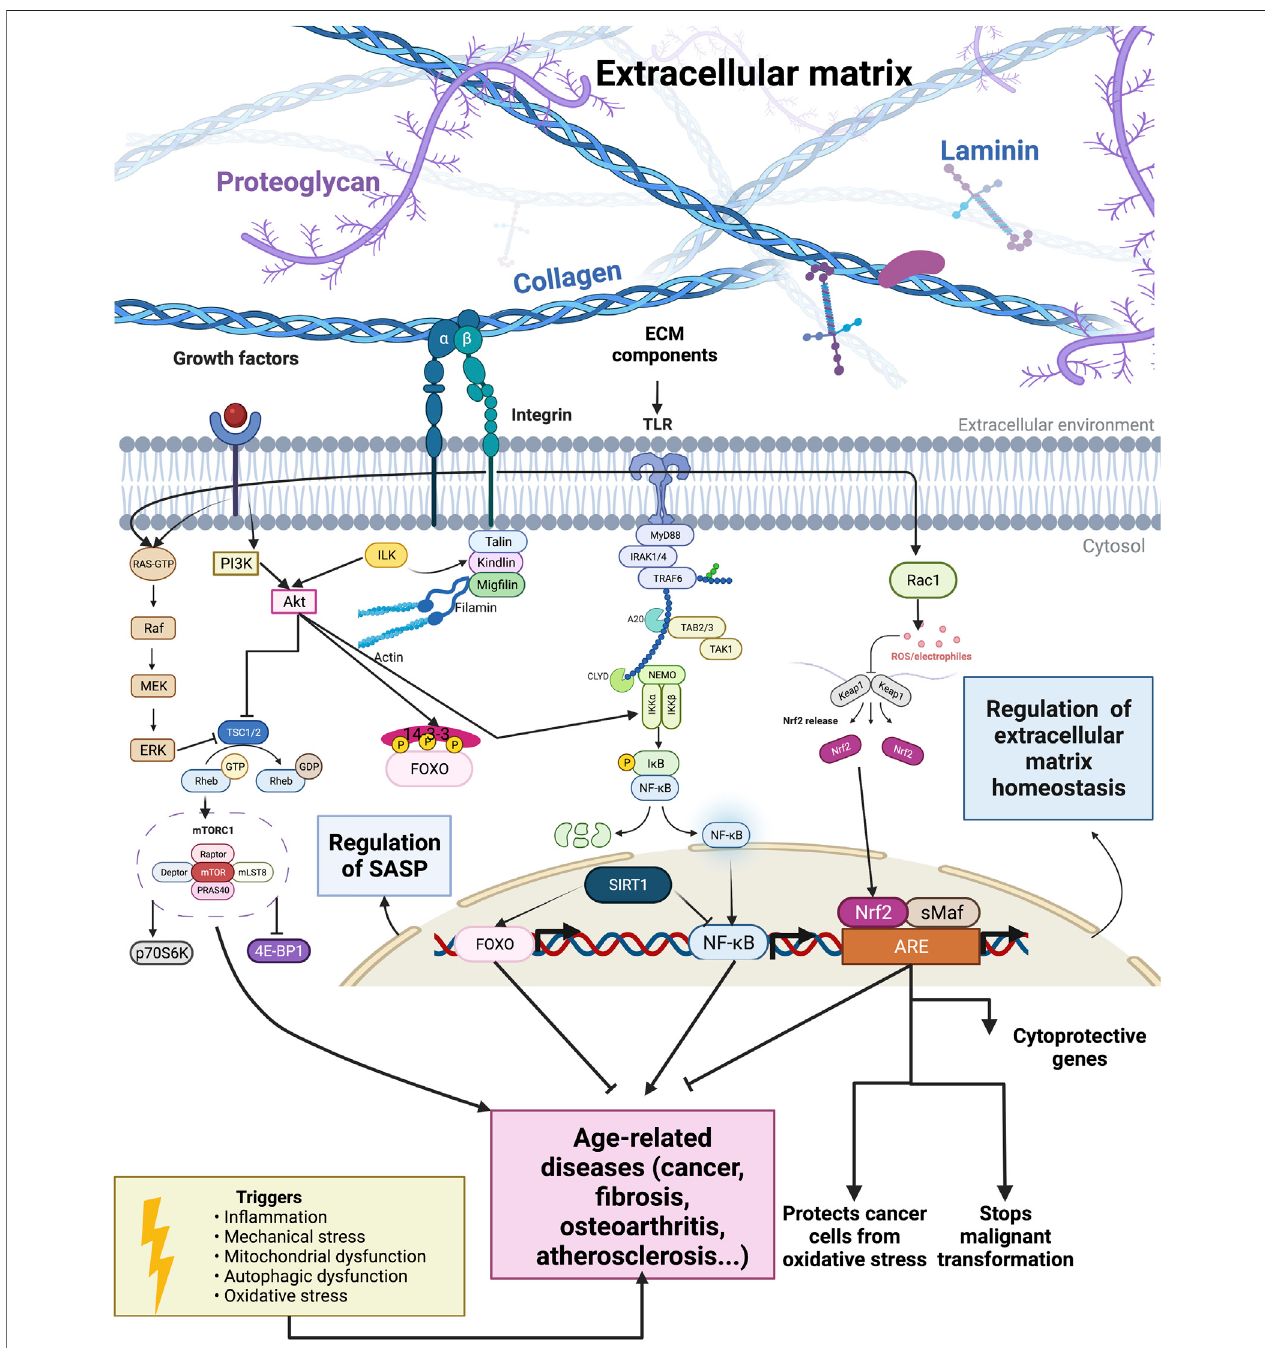
FIGURE 1 | Outside-in and inside-out interplay of longevity pathways and extracellular matrix components. Extracellular matrix components in fl uence longevity pathways and transcription factors. Constitutive activation of the mTOR signaling pathway and transcription factor NF- κ B can lead to the development of age-related diseases. By contrast, FOXO, NRF2, and sirtuins activation relate to an increased lifespan.